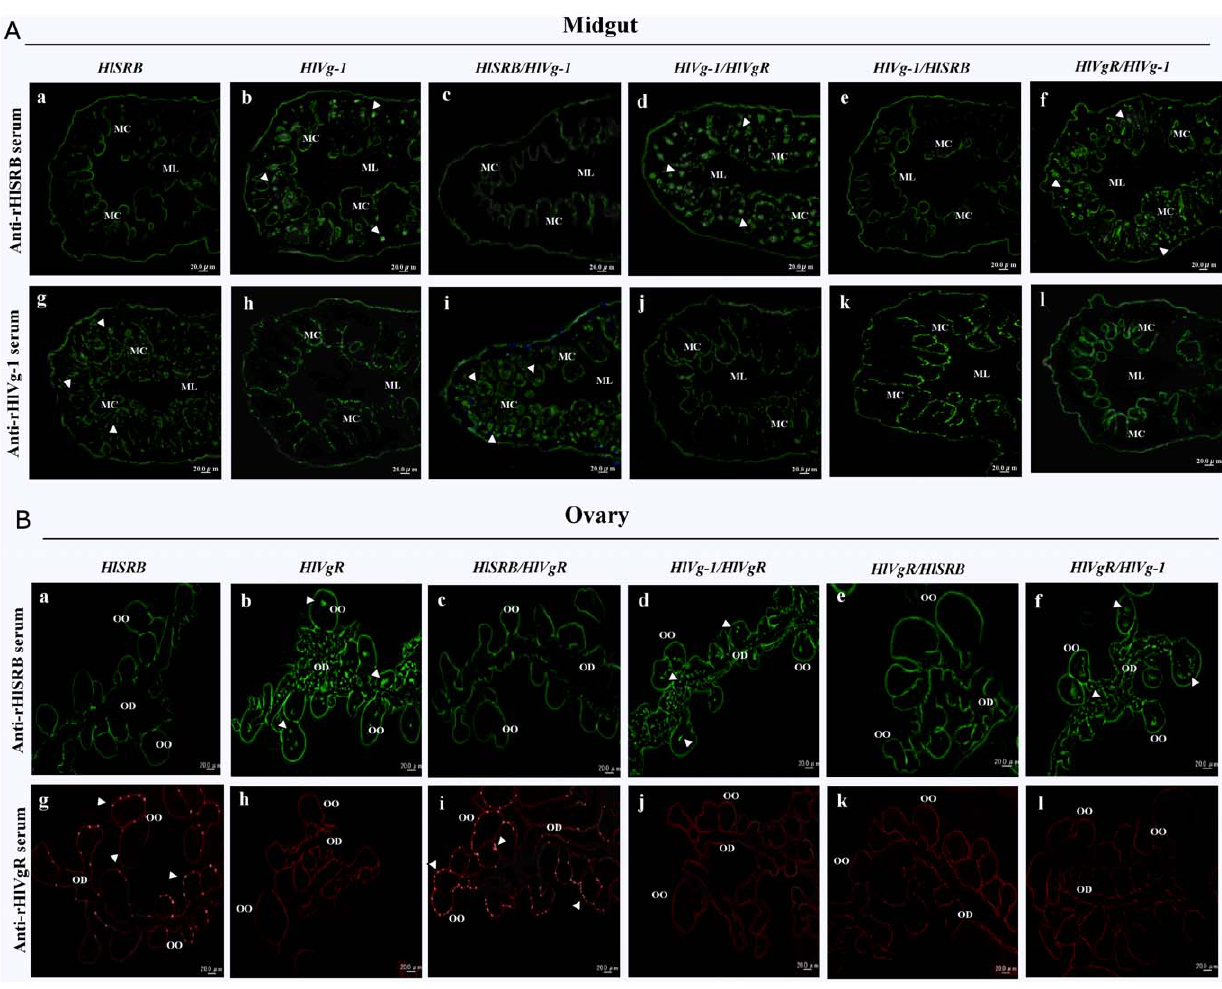
Figure 4. Confirmation of RNAi on the endogenous HlSRB, HlVg-1, and HlVgR in the different tissues of H.longicornis . The dissected tissues from the dsRNA-injected 4-days-feeding ticks were observed under fluorescence microscopy. The name of each dsRNA group is indicated above. The midguts were stained with anti-rHlSRB and anti-rHlVg-1 antibodies followed by Alexa 488-conjugated mouse anti-IgG with DAPI (A). Arrowheads indicate the native HlSRB and HlVg-1 expressed in the midguts. ML, midgut lumen; MC, midgut cells. The ovaries, staining pattern of anti- rHlSRB and anti-rHlVgR serum were used as first antibodies (B). The mouse anti-IgG conjugated with Alexa 488 was used as a second antibody with DAPI for the upper panels and Alexa 594 with Propidium Iodide for the lower panels. Arrowheads indicate the native HlSRB and HlVgR expressed in the ovaries. OO, oocyte; OD, oviduct. The scale bar represents 20 m m.